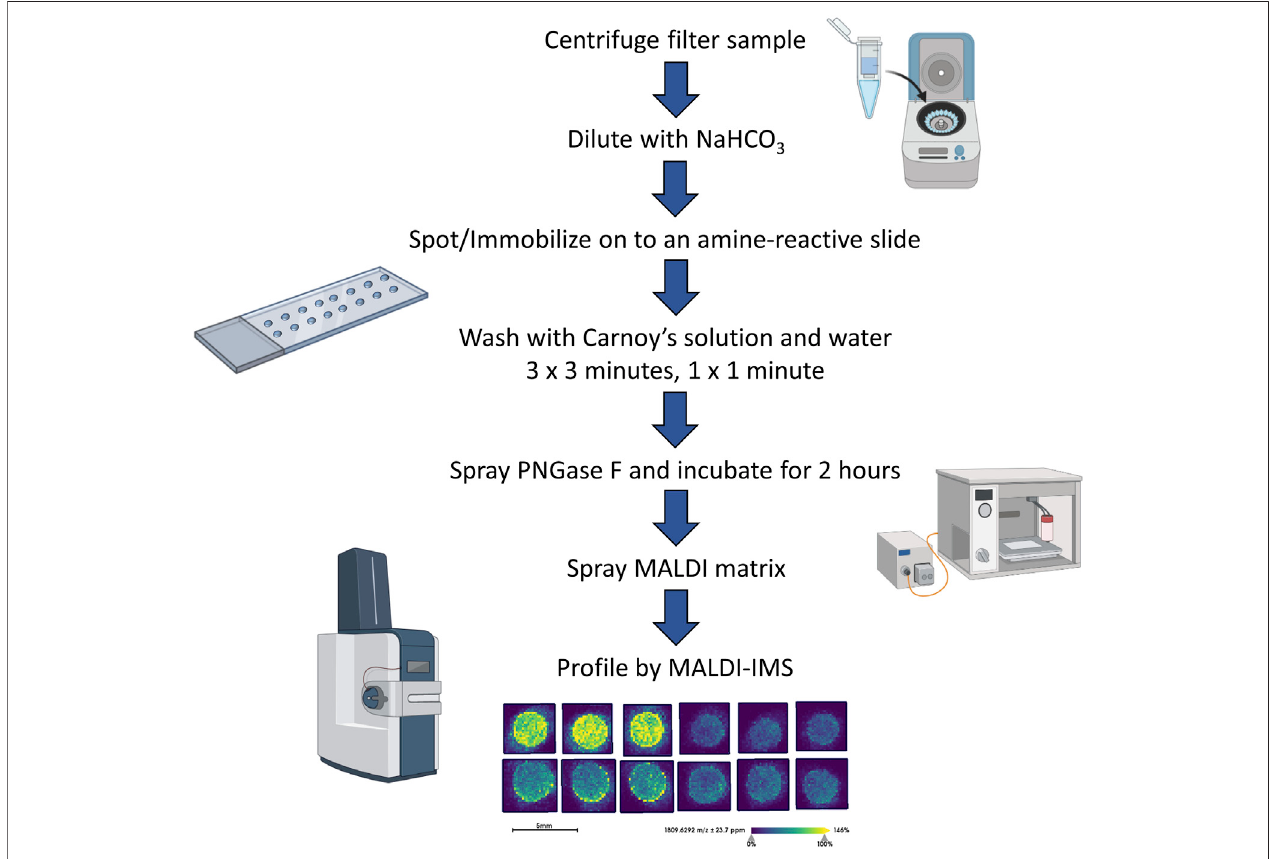
FIGURE 1 | Work fl ow of the EPS fl uid and urine N-glycan analysis.